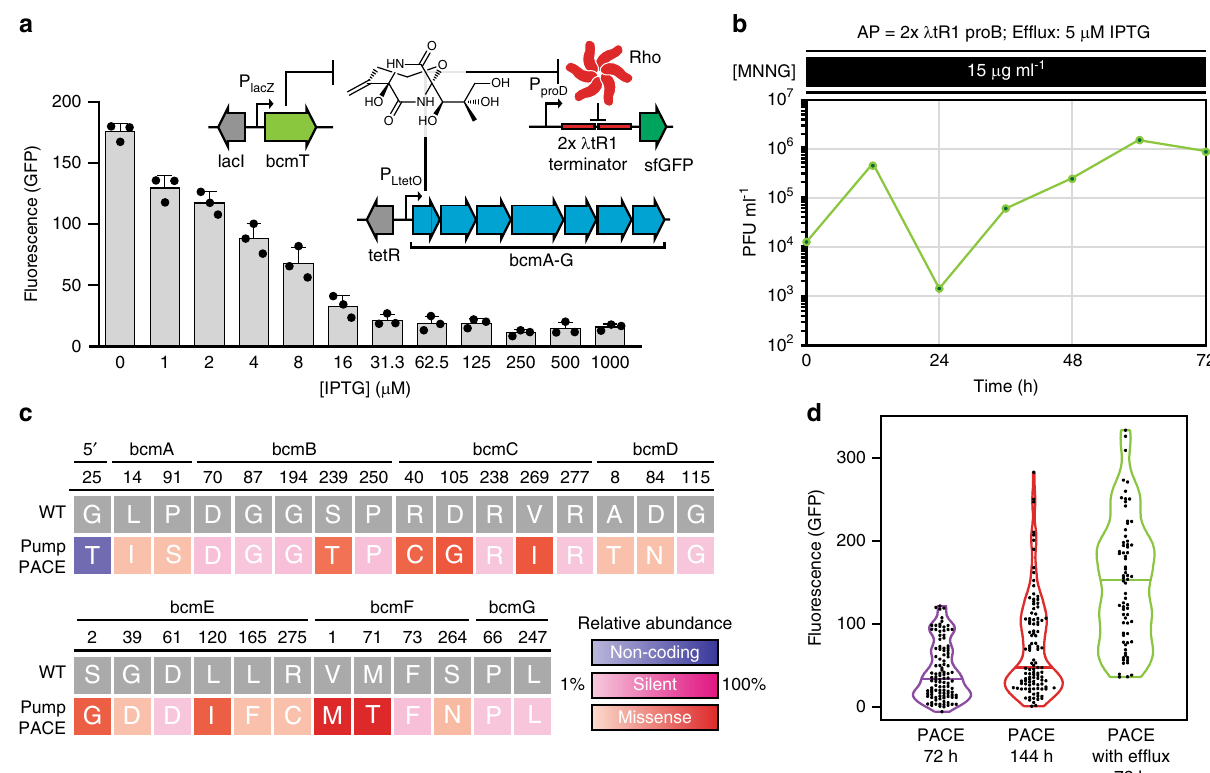
Fig. 3 BCM ef fl ux during PACE yields a more productive population of BGCs. a Fluorescence (GFP) signal from BCM reporter plasmid pREP.2 in E. coli cells carrying the IPTG-inducible BCM ef fl ux pump expression plasmid pPUMP and evolved BCM production plasmid pBCM.1 (recovered PACE clone 72.5). Results are absorbance normalized signal over uninduced controls, shown as mean ± s.d.; n = 3 biological replicates. b SP BCM titers (plaque forming units, PFU) over an additional 72 h of PACE, using S2060 E. coli carrying accessory plasmid pAP.1 and the IPTG-inducible ef fl ux pump expression plasmid